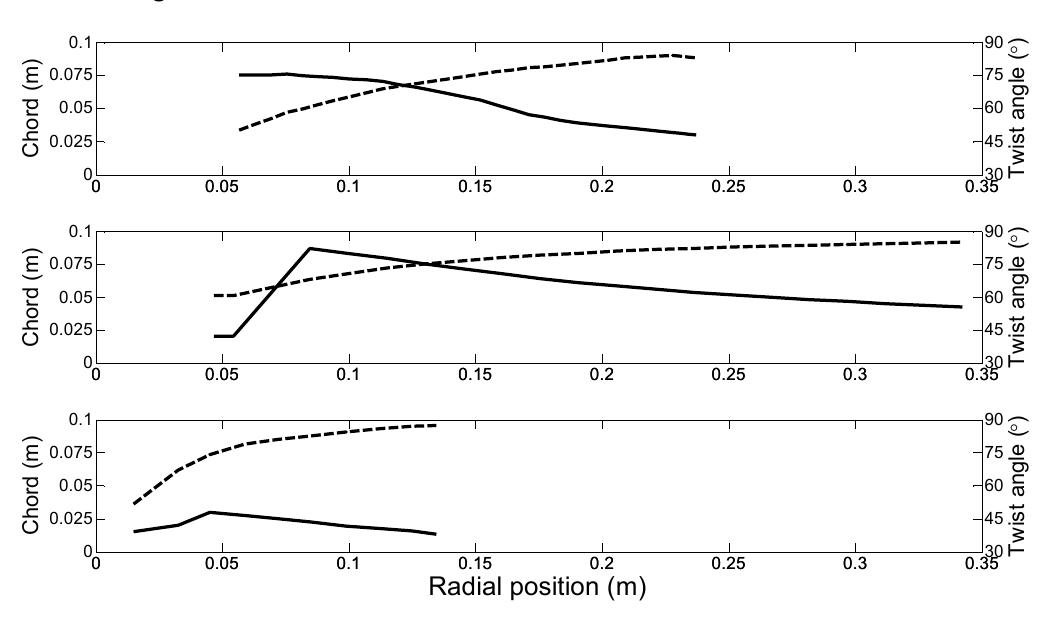
Figure 1. Blade geometries for the ( top ) Liverpool, ( middle ) IFREMER and ( bottom ) Manchester turbines. Chord length (distance from the section leading edge to the trailing edge) is shown with solid lines and the twist angle with dashed lines (90° meaning the section is parallel to the rotor